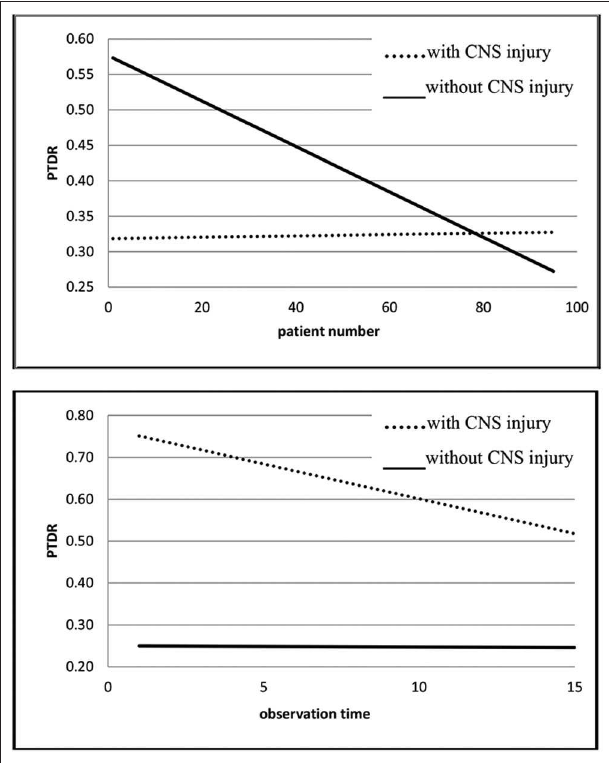
FIGURE 3 | The relationship of PTDR rates for patients with and without CNS injury.